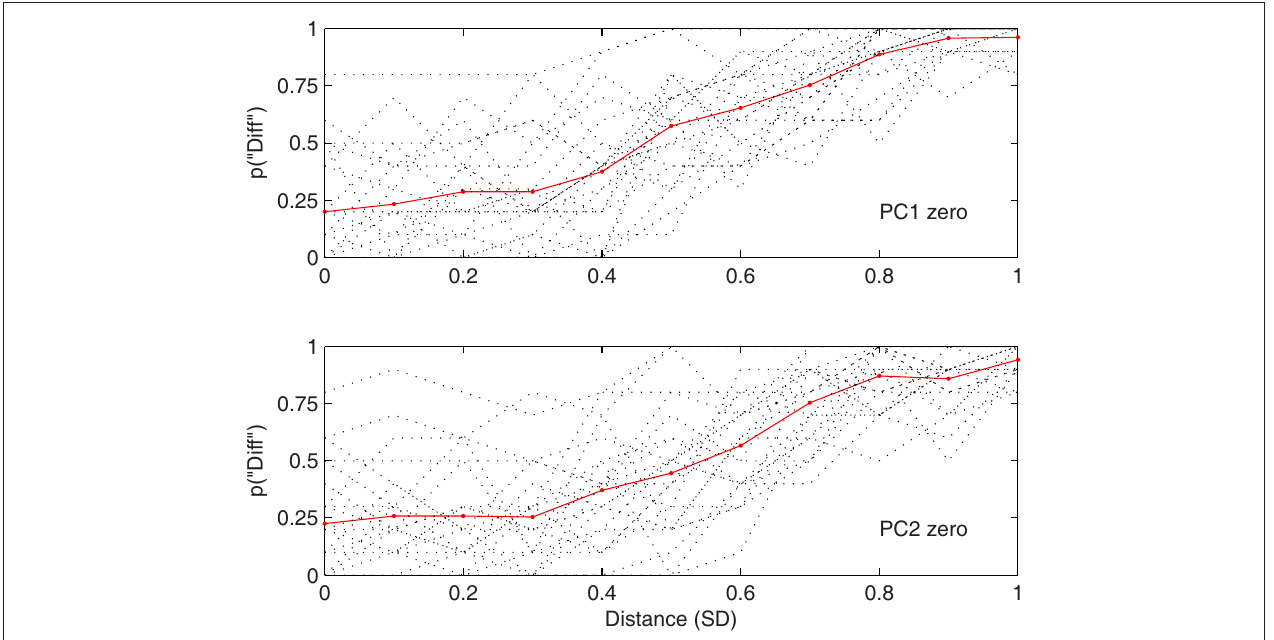
Figure 4 | Proportion “different” responses as a function of physical difference in SD units for the two conditions of experiment 2. Dotted lines indicate individual psychometric functions and solid red lines combined